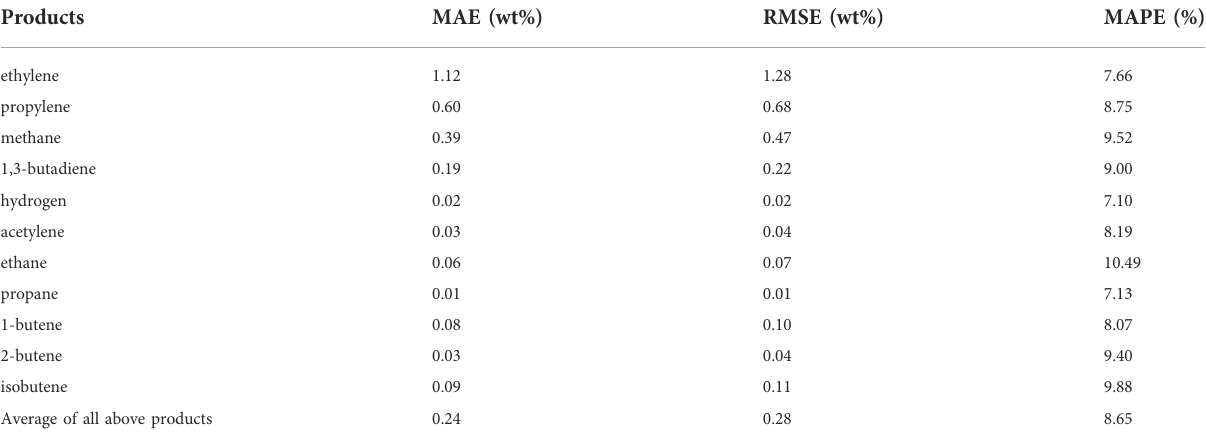
TABLE 4 Statistics on the performance of the 11 cracking products of reactor